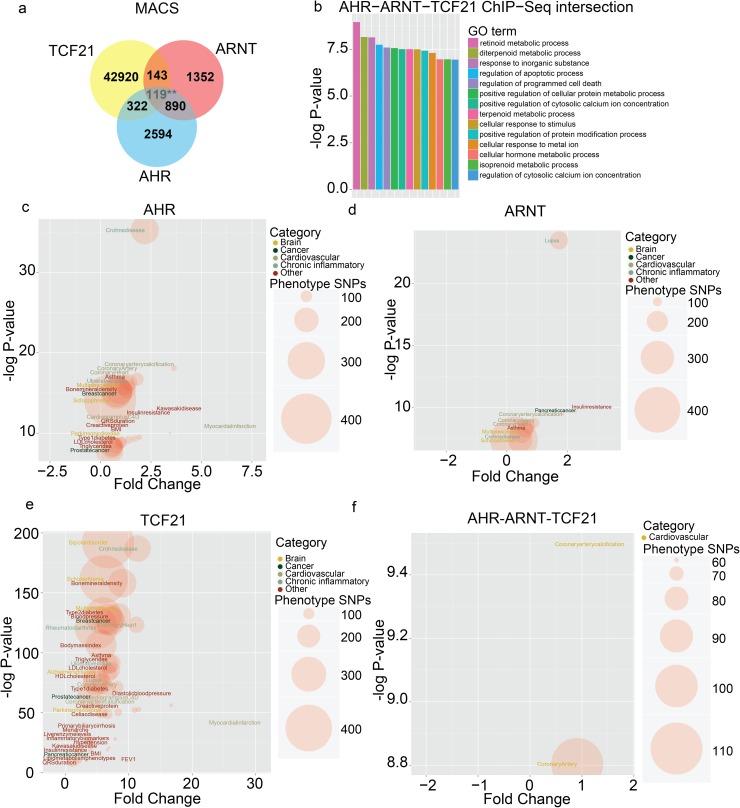
ChIP-seq data show co-localization of TCF21, AHR and ARNT binding in loci containing genes related to inflammation and programmed cell death.(a) Venn diagram showing intersection of the TCF21, AHR and ARNT ChIP-seq peaks. Note that the shown number of overlapping AHR-ARNT-TCF21 sites is colored in light gray to indicate that it is a subgroup of the shown intersections of individual pairs. (b) GO terms related to the overlap of TCF21, AHR and ARNT ChIP-seq sites. GO terms were defined using 119 overlapping sites from a, and by identification of related genes with GREAT. Calcium signaling GO terms are noted to represent a broad array of cytokines and chemokines in addition to other types of molecules. (c) Overlap of AHR ChIP-seq binding sites and GWAS SNPs in a window of +/-2000bp. GWAS SNPs were obtained from the GWAS Catalog, parsed into categories and the binomial enrichment of overlap with the AHR ChIP-seq sites was calculated for each parsed category. Plotted are binomial fold change vs.–log binomial p-value and terms were colored according to the four major categories: brain, cancer, cardiovascular, chronic inflammatory. (d) Overlap of ARNT ChIP-seq binding sites and GWAS SNPs in a window of +/-2000bp. (e) Overlap of TCF21 ChIP-seq binding sites and GWAS SNPs in a window of +/-2000bp. (f) Overlap of AHR-ARNT-TCF21 ChIP-seq binding sites and GWAS. SNPs in a window of +/-2000bp.